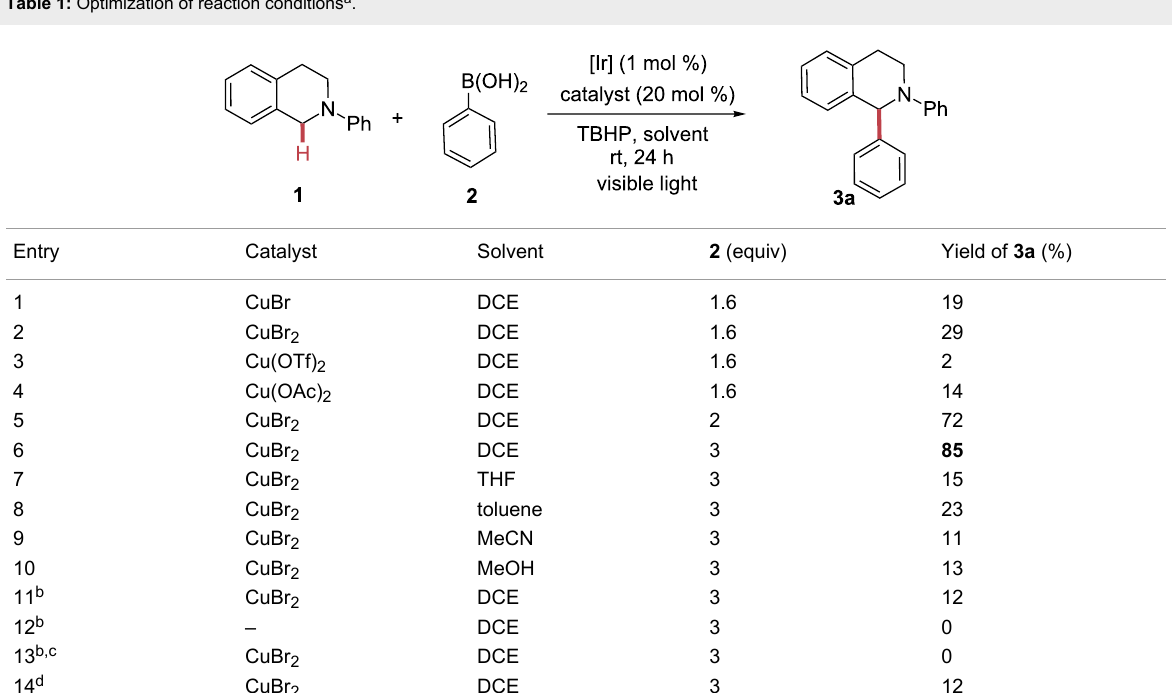
Table 1: Optimization of reaction conditions a .